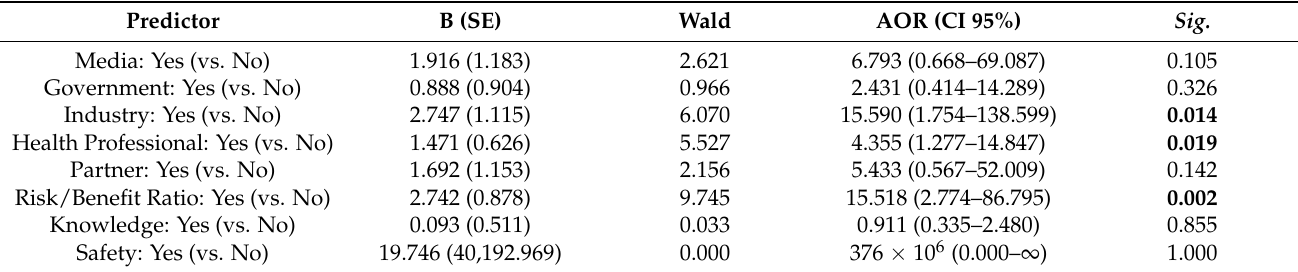
Table 10. Psychosocial predictors of COVID-19 vaccine acceptance among pregnant women, University Hospital Brno, August–October 2021 ( n =